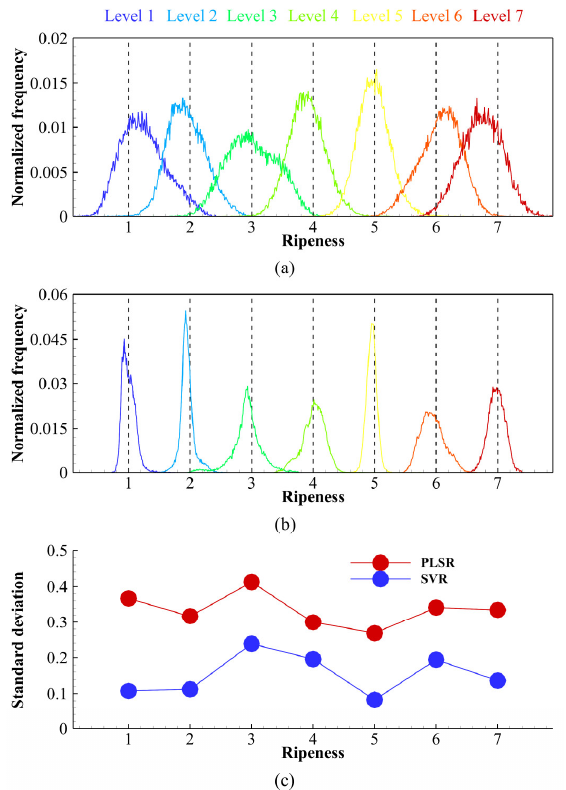
Figure 8. The normalized histograms of ripeness value distributions of typical fruit samples at different ripeness stages classified by ( a ) PLSR and ( b ) SVR models. ( c ) The related standard deviations of histograms.